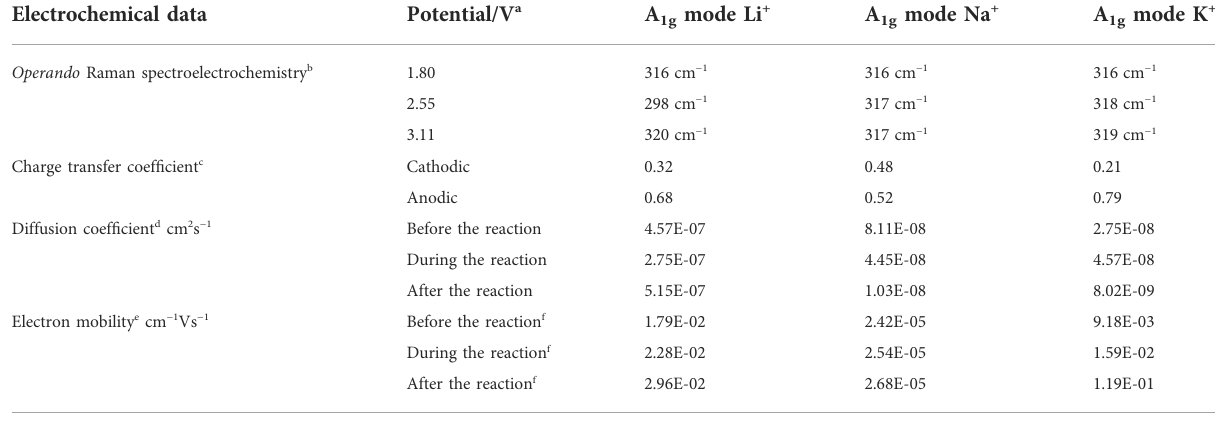
TABLE 2 Changes within the A 1g Raman active mode at potentials indicated in Figure 3, diffusion coef fi cients extracted from the PITT, electron mobility extracted from the SPEIS measurement and kinetic merits of lithiation based on Butler-Volmer analysis. Corresponding Figures were gathered in the Supplementary Information (Supplementary Figures S9 –